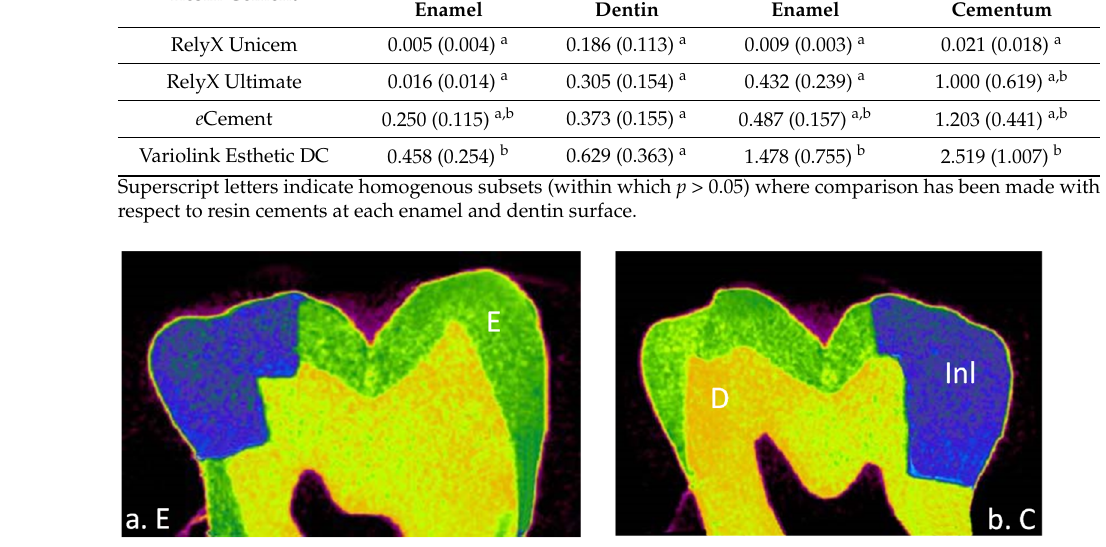
Figure 1. Micro-CT images of internal and marginal gap at the gingival floor of a Class II Lava Ultimate inlay luted with RelyX Unicem resin cement on ( a ) enamel and ( b ) cementum/dentin. Inl, inlay; E, enamel; D, dentin.